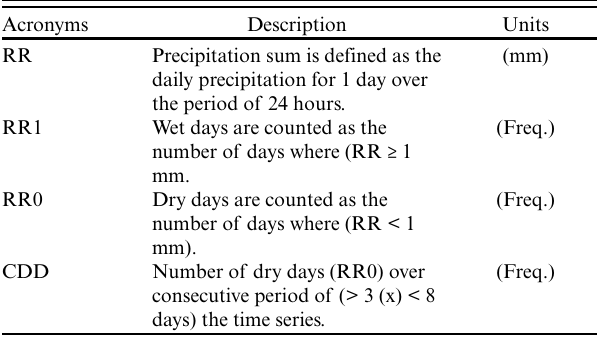
Table 2 . Rainfall index description. Source: ECA&D Project Team